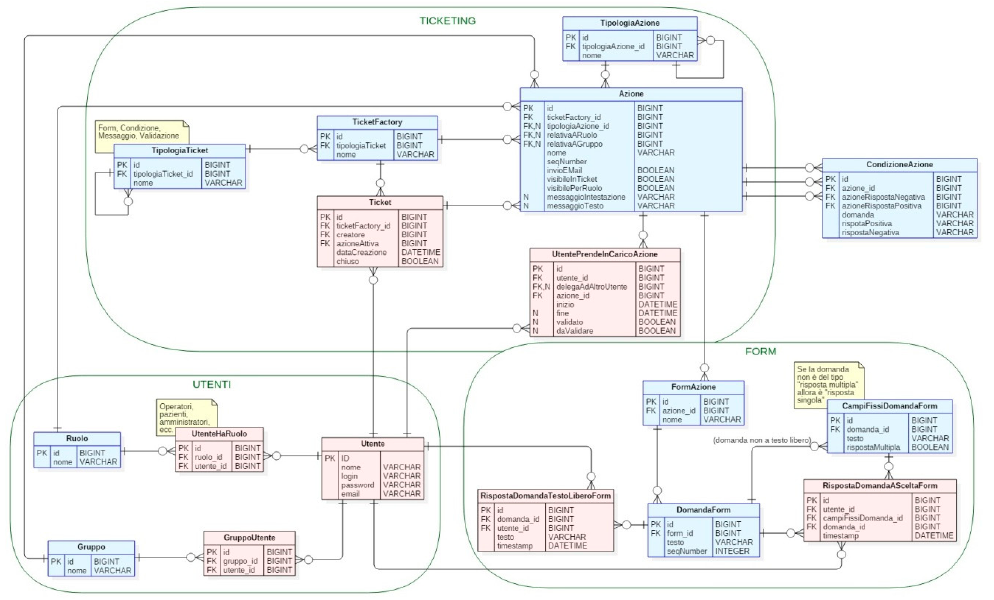
Figure A1. Entity-association diagram of the ticketing service.